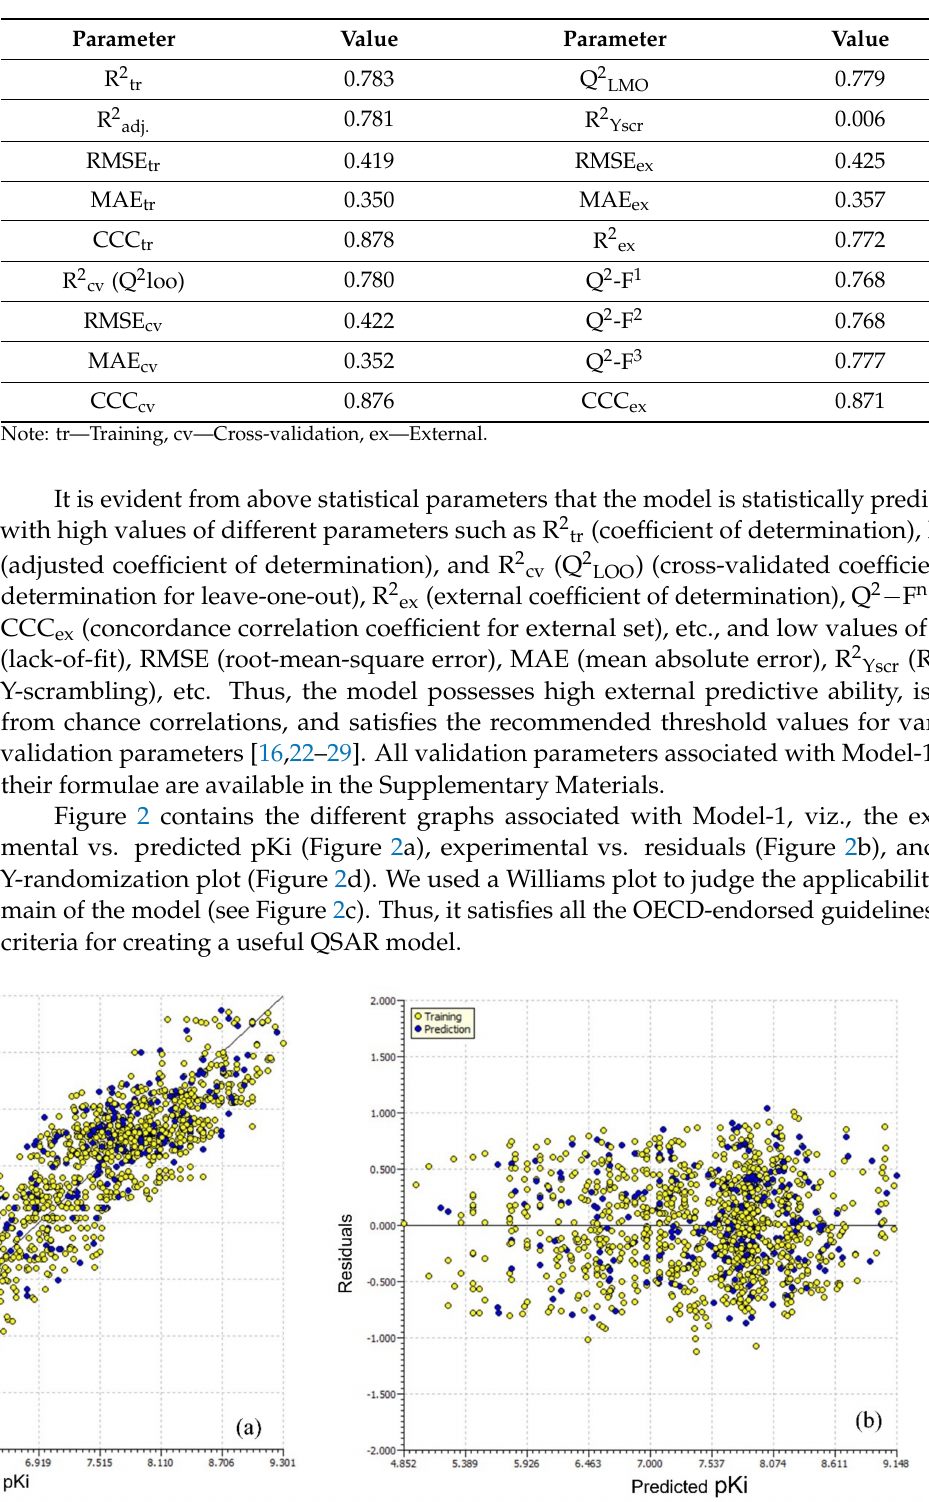
Table 2. Selected statistical validation parameters for